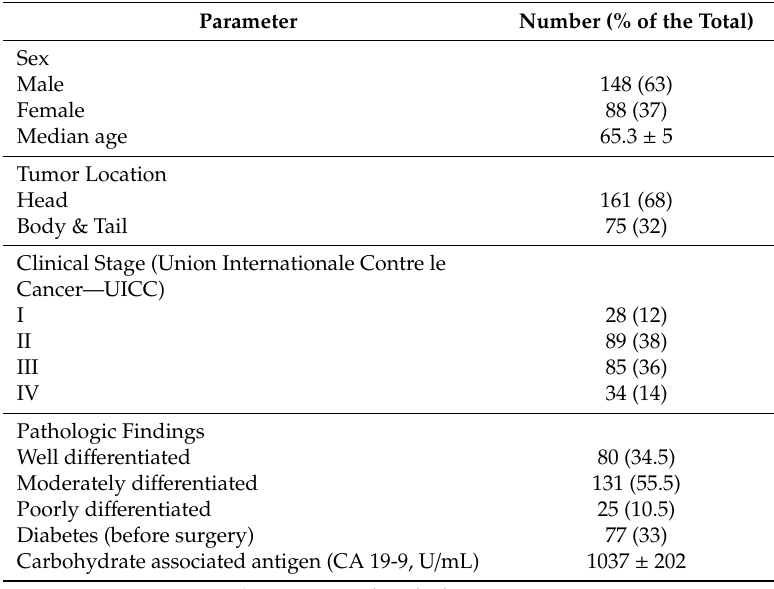
Table 1. Demography of PDAC